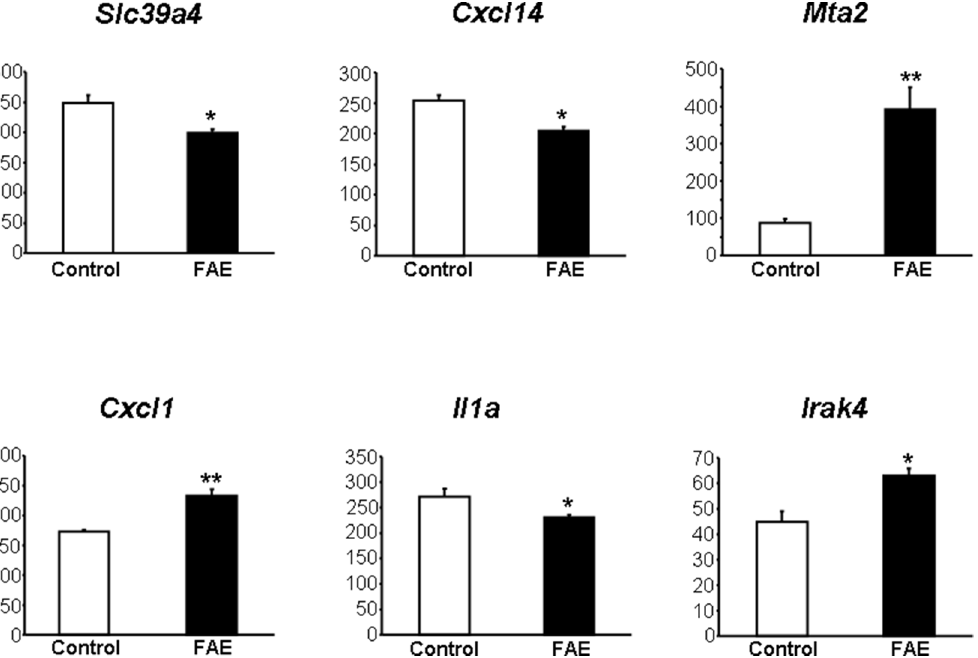
Figure 4. Validation of gene expression profiles obtained by Affymetrix transcriptional profiling by quantitative real time PCR for six transcripts in livers isolated from SHR-CRP rats treated with fumaric acid esters (FAE) (solid bars) versus untreated SHR-CRP controls (open bars). Expression of selected genes was normalized relative to the expression of the peptidylprolyl isomerase A ( Ppia ) gene, which served as an internal control.